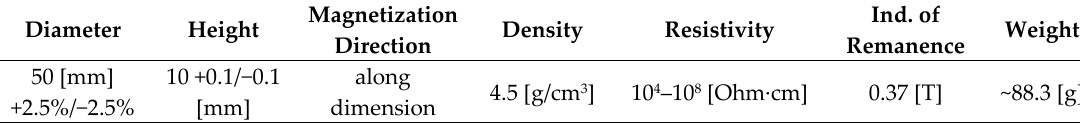
Table 1. Characteristics of the magnets used for the experiment [1].